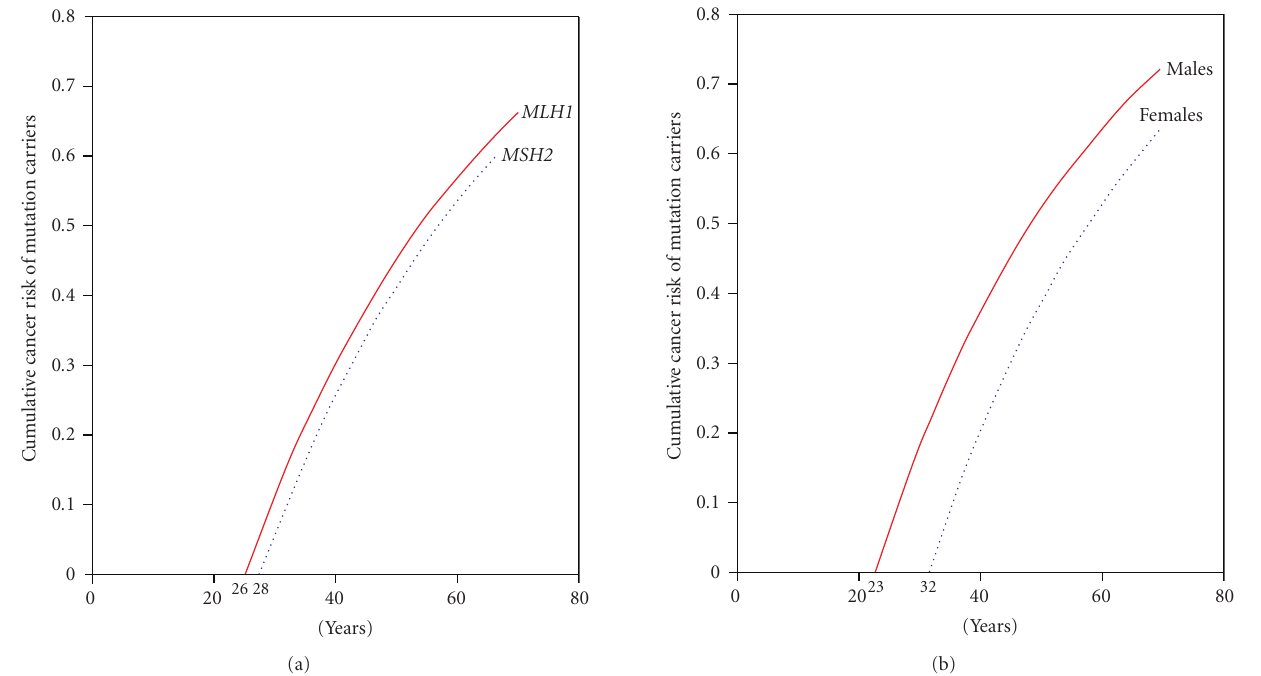
Figure 2: Cumulative risk of cancer for mutation carriers when individuals are di ff erentiated with respect to the mutated gene (part (a)) or gender (part (b)). The risk estimation was only attempted under the assumption that the risk follows a modified Weibull distribution as a function of